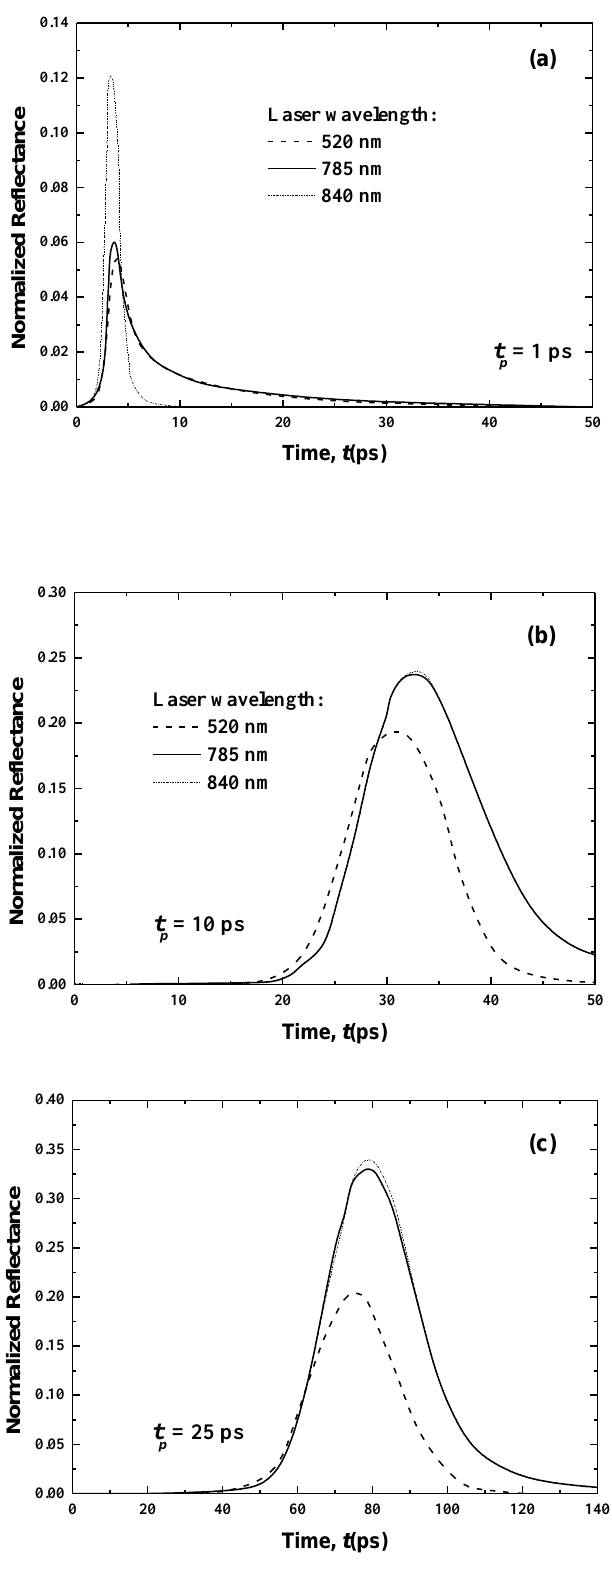
Figure 9. Temporal signals of the normalized reflectance from the normal skin at different wavelengths for laser pulse widths of ( a ) 1 ps, ( b ) 10 ps and ( c ) 25 ps.